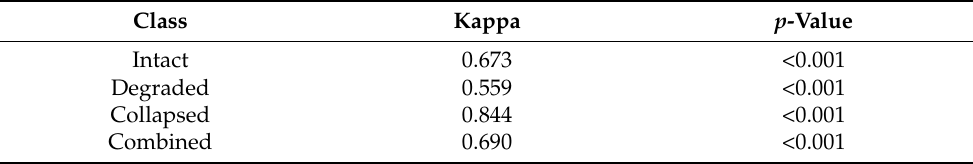
Table 4. Results for Fleiss’ Kappa for four assessors for each class.